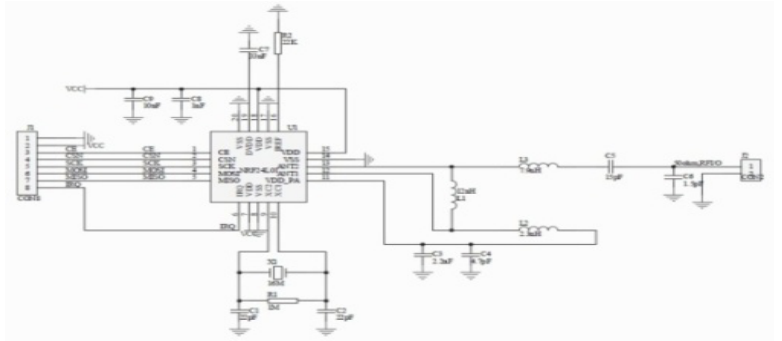
Fig. 5. Schematic diagram of nRF24L01